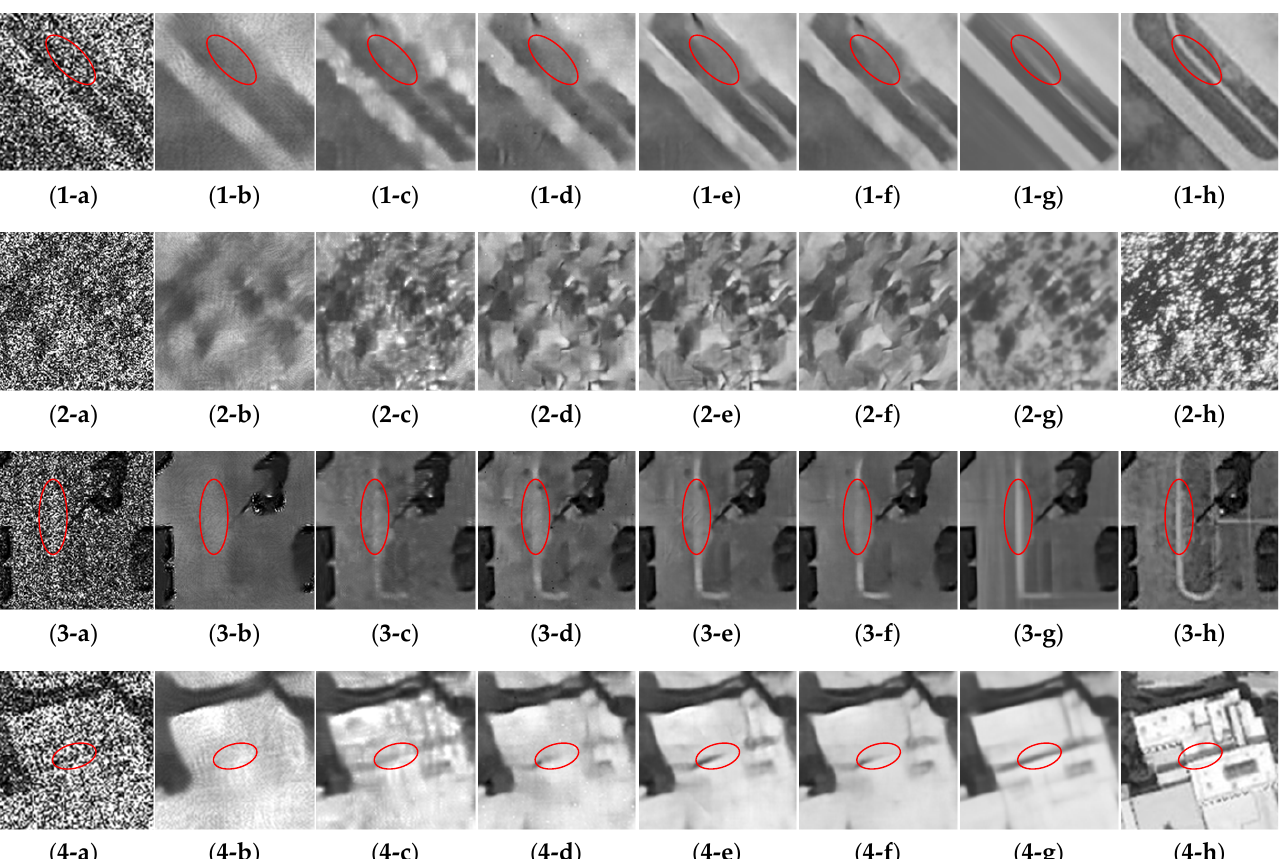
Figure 10. Magnified results for synthetic speckled images. In the subgraph number, ( 1 ) denotes Airport , ( 2 ) denotes Beach , ( 3 ) denotes Parking , and ( 4 ) denotes School . ( a ) Speckled. ( b ) PPB. ( c ) SAR-BM3D. ( d ) ID-CNN. ( e ) SAR-DRN. ( f ) SAR-RDCP. ( g ) Proposed SSD-SAR-BS. ( h ) Speckle-free